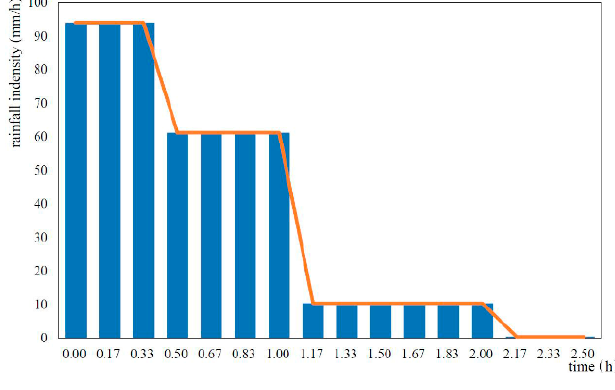
Figure 17. The hyetography in the study area. Table 4. Infiltration rate (mm/h) and Manning coefficient (s/m 1/3 ) under different land use